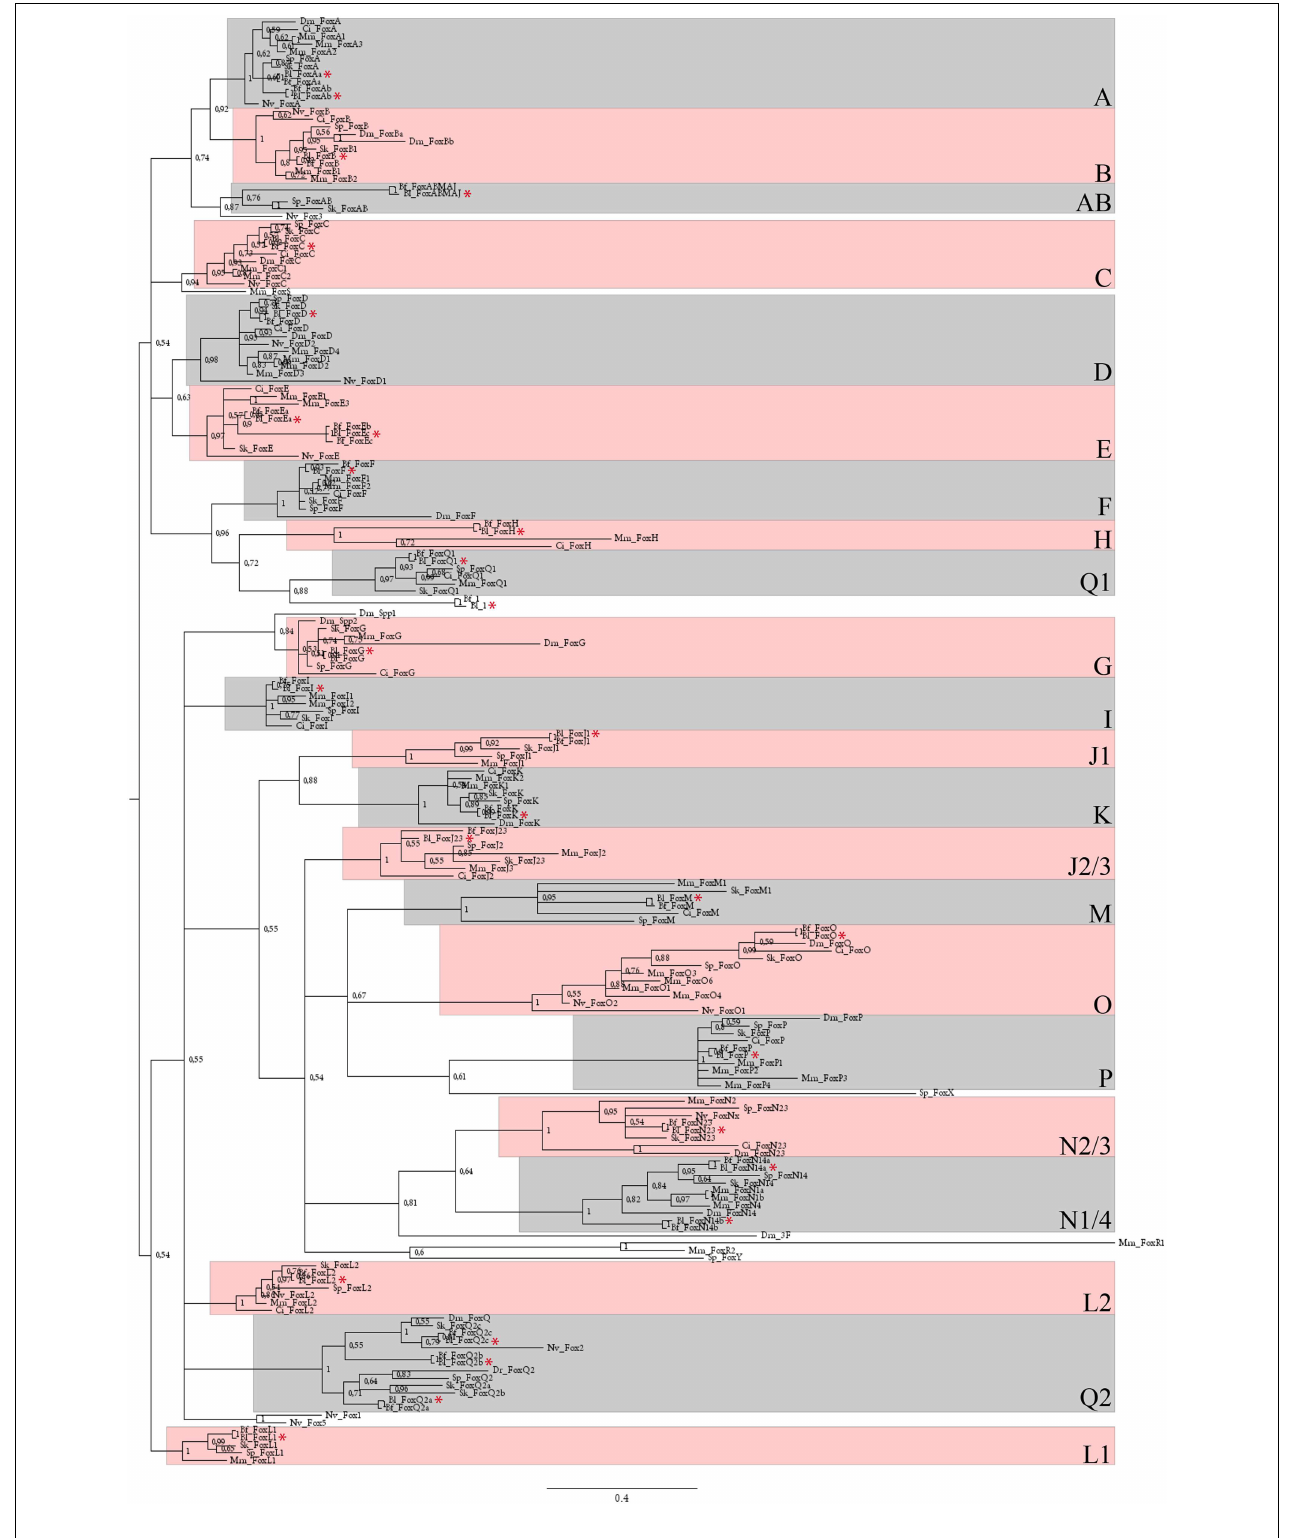
blue boxes. Divergent sequences appeared outside these boxes. Only one amphioxus Fox gene, named Fox1 (Yu et al., 2008a), that probably originated by a specific duplication and fast evolutionary rate in cephalochordates,